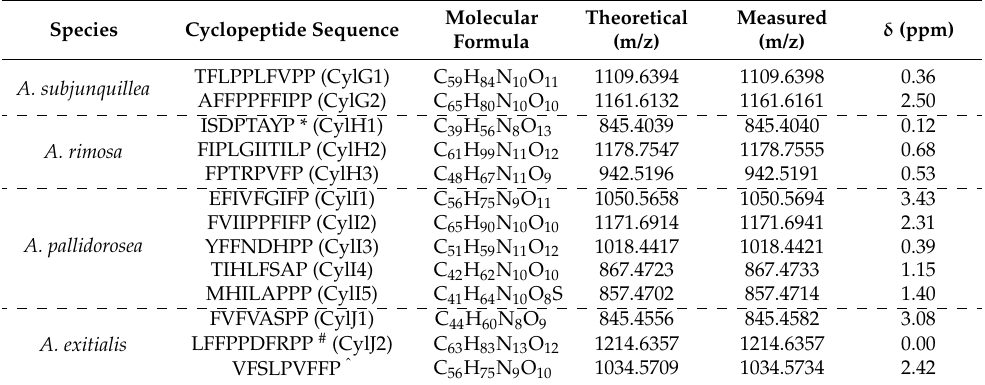
Table 4. Twelve novel cyclic peptides and one known cyclic peptide discovered in Amanita subjun- quillea , A. rimosa , A. exitialis , and Amanita pallidorosea. Molecular Species Cyclopeptide Sequence